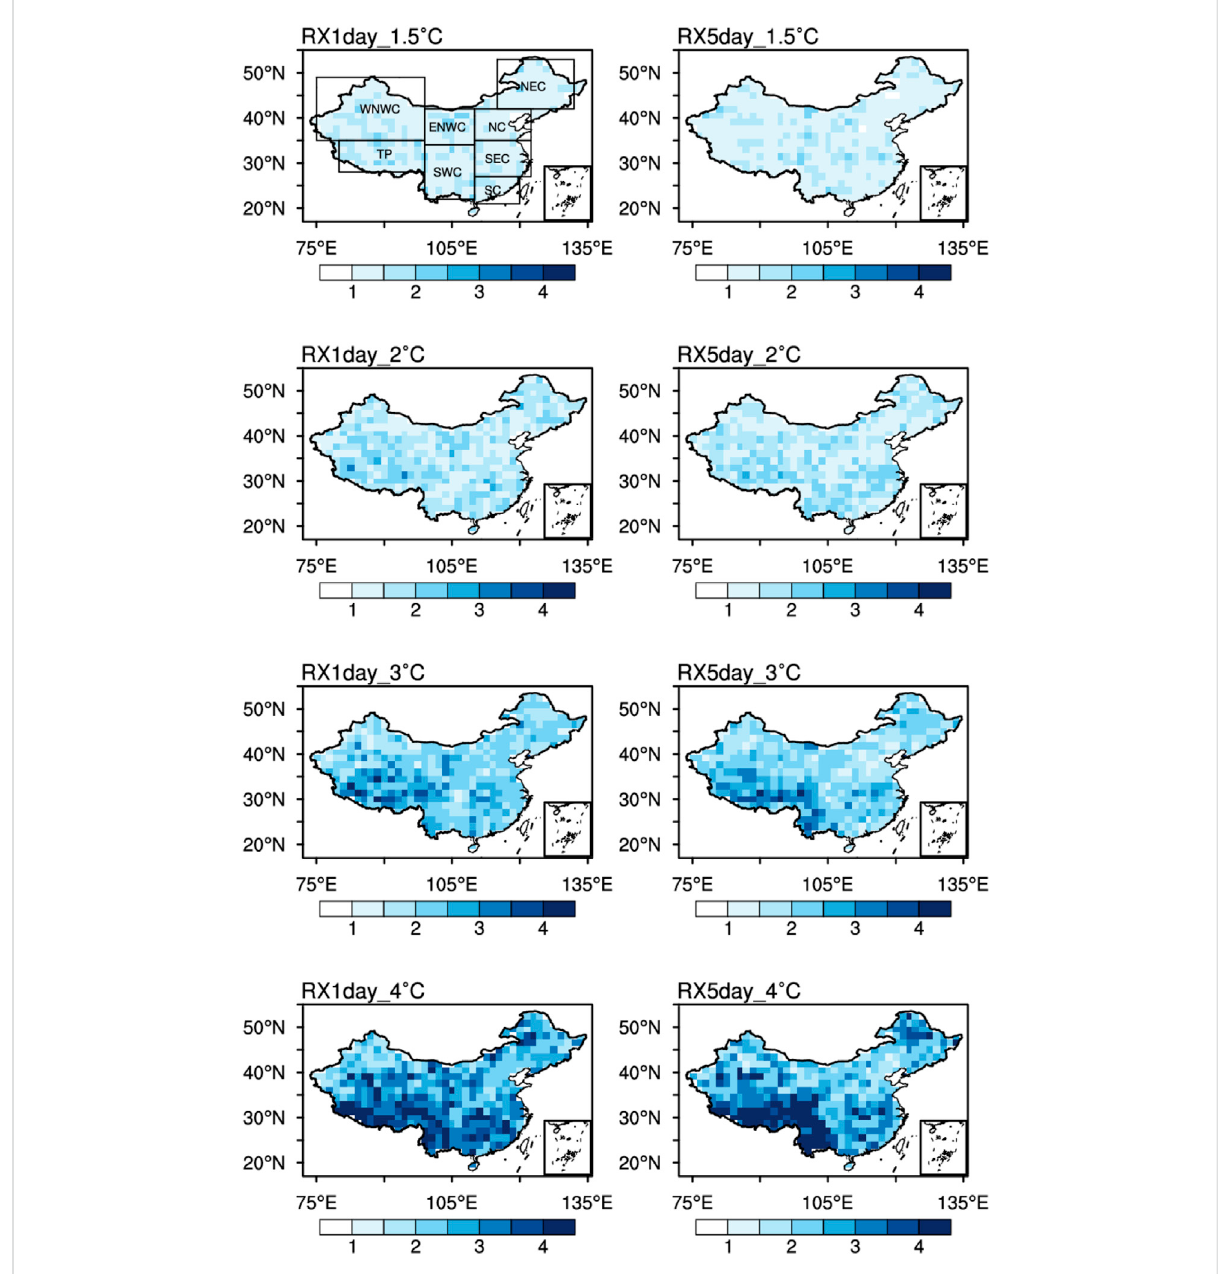
FIGURE 4 Spatial patterns for the PRs of the occurrence of 10-year RX1day and RX5day over China under the 1.5 – 4.0 ° C warmer climate under the SSP5- 8.5scenariowithrespecttothecurrentclimate(1995 – 2014).TheoccurrenceprobabilityofprecipitationextremesisexpectedtoincreaseifthePRis larger than